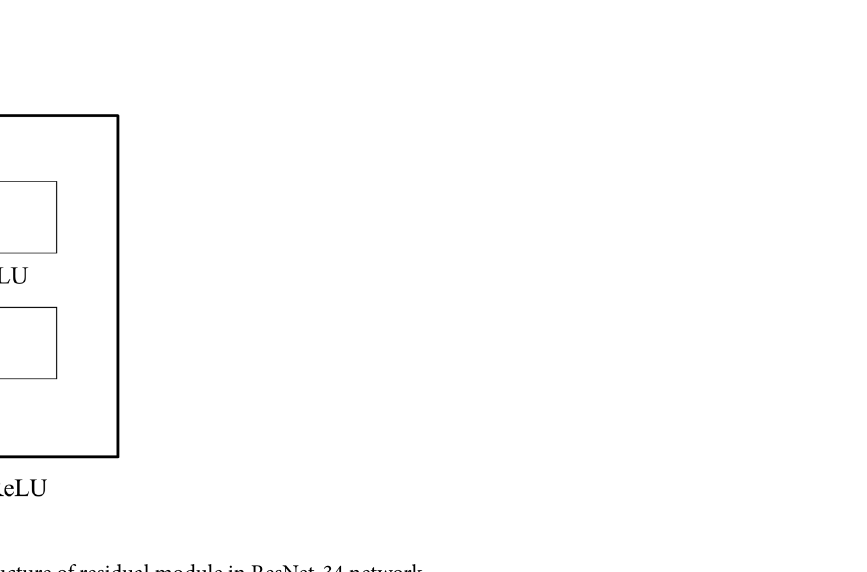
Figure 6. The structure of residual module in ResNet-34